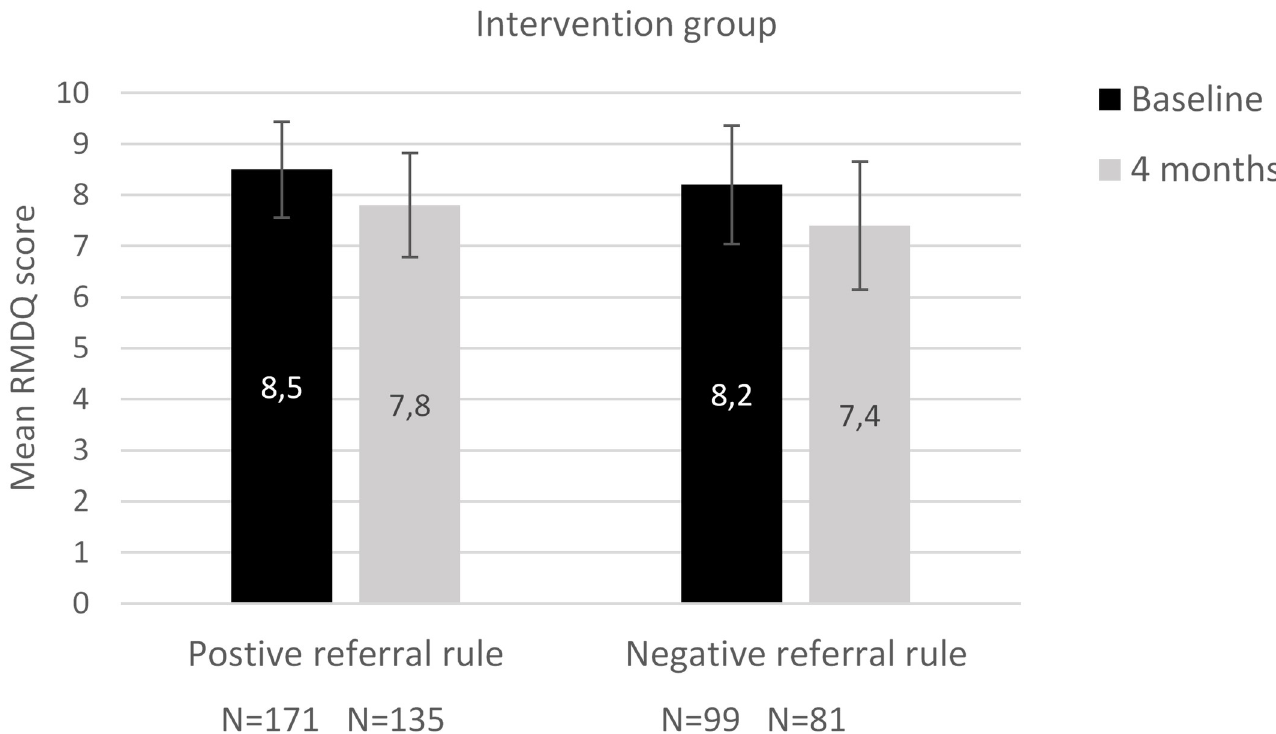
Fig 3. Difference in mean RMDQ scores over time within the intervention group, for patients receiving positive and negative referral strategy. Bars indicate 95% confidence intervals for the mean estimates.